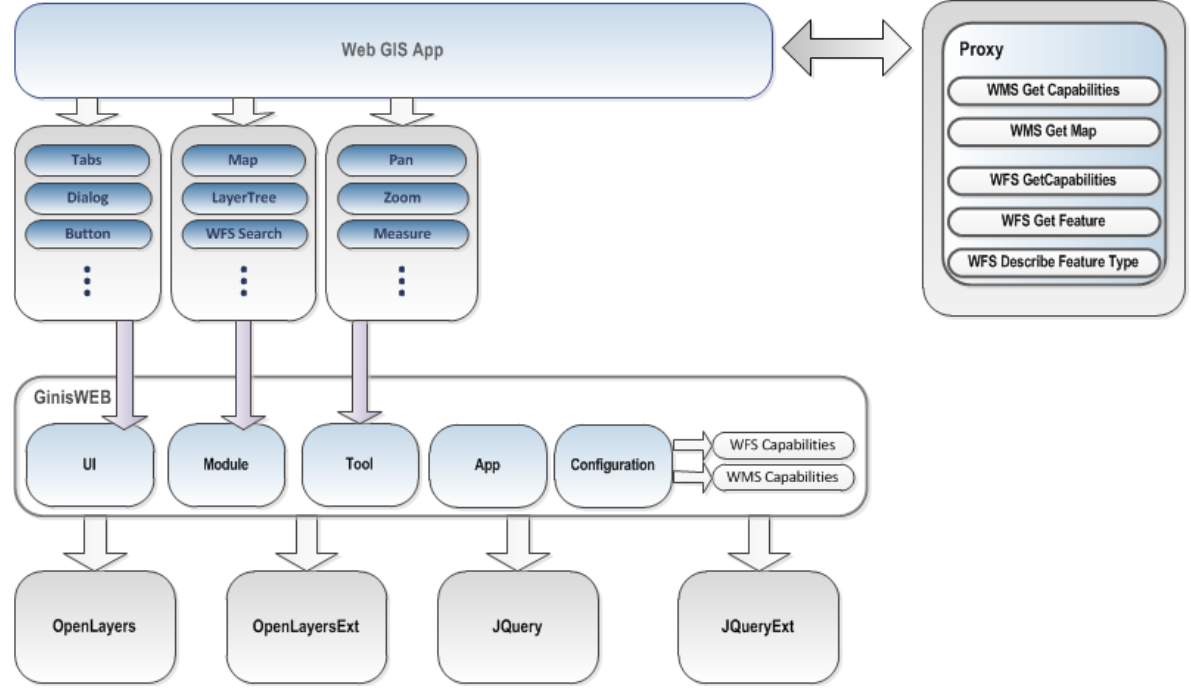
Figure 4. The architecture of the Web GIS client